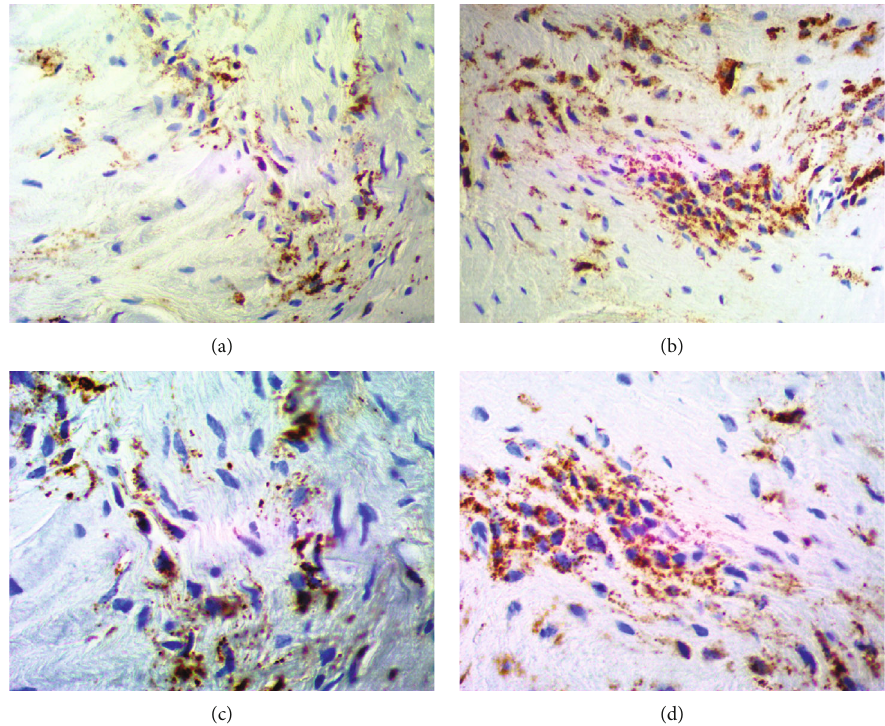
Figure 2: The representative microphotographs showing CX3CR1 expression in examined synovial membrane slices. (a) Synovial membrane from hemophilic arthropathy patient ( × 200 magni fi cation). (b) Synovial membrane from osteoarthritis patient ( × 200 magni fi cation). (c) Synovial membrane from hemophilic arthropathy patient ( × 400 magni fi cation). (d) Synovial membrane from osteoarthritis patient ( × 400 magni fi